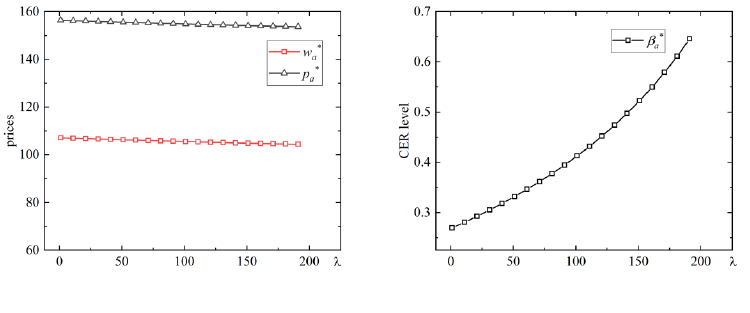
Figure 2. The Influence of Carbon Emission Reduction Cost 𝑘 on Supply Chain Decision.